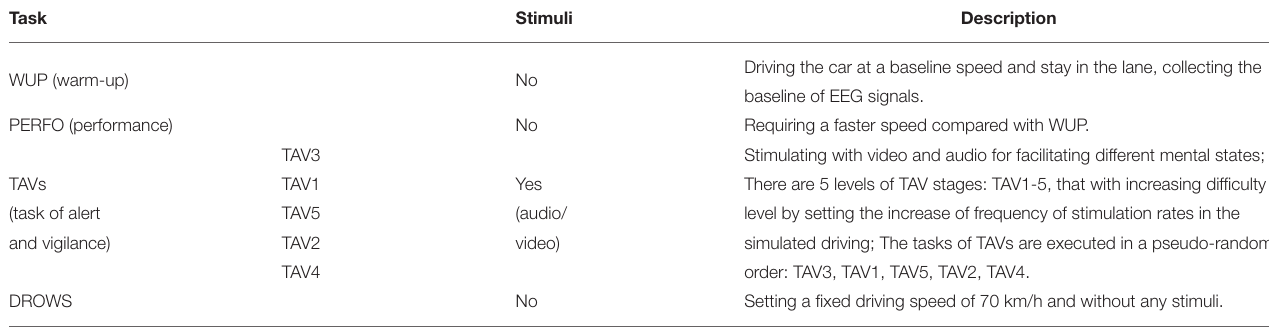
TABLE 1 | The details of the experiment tasks. Task Stimuli